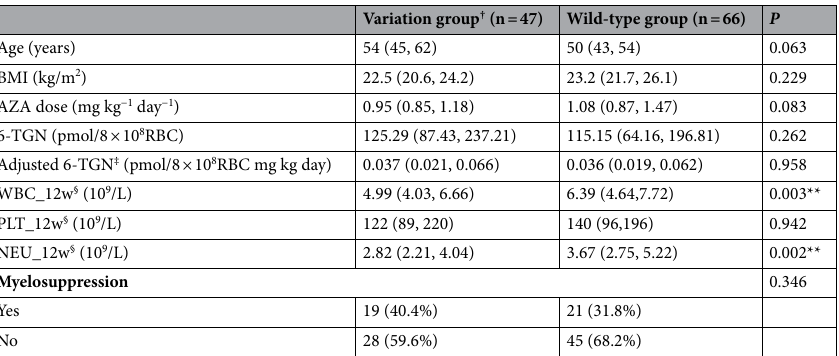
Table 3. Analysis of related indicexes between patients with genetic variation and wild-type patients [median(IQR)]. BMI body mass index, AZA azathioprine, 6-TGN 6-thioguanine nucleotides, WBC white blood cell count, PLT platelet count, NEU neutrophil count, RBC red blood cell. † At least one variant allele in TPMT*3C (rs1142345), ITPAc.94C > A (rs1127354) or NUDT15c.415C > T (rs116855232) . ‡ 6-TGN